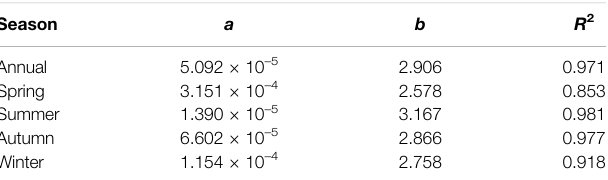
TABLE 2 | Parameters of the length – weight relationship for Acanthopagrus schlegelii .